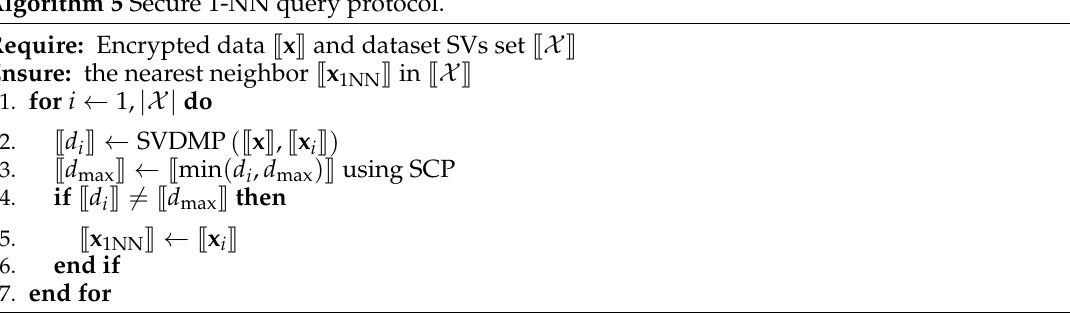
Algorithm 5 Secure 1-NN query